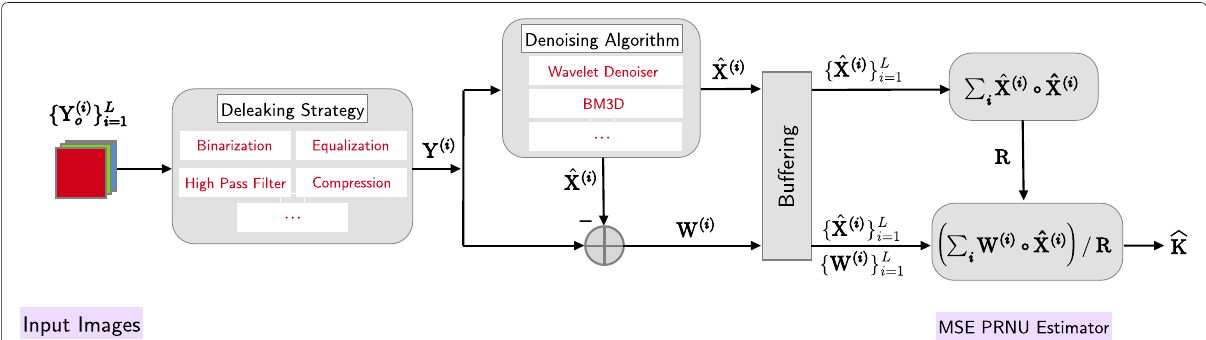
Fig. 1 Block diagram of the ML PRNU estimation process from a set of L images { Y ( i ) o } L i = 1 considered in this paper, jointly with the different variables involved in the process. For each block, all the possible operations are highlighted in red. The deleaking strategy block may not be used in some experiments